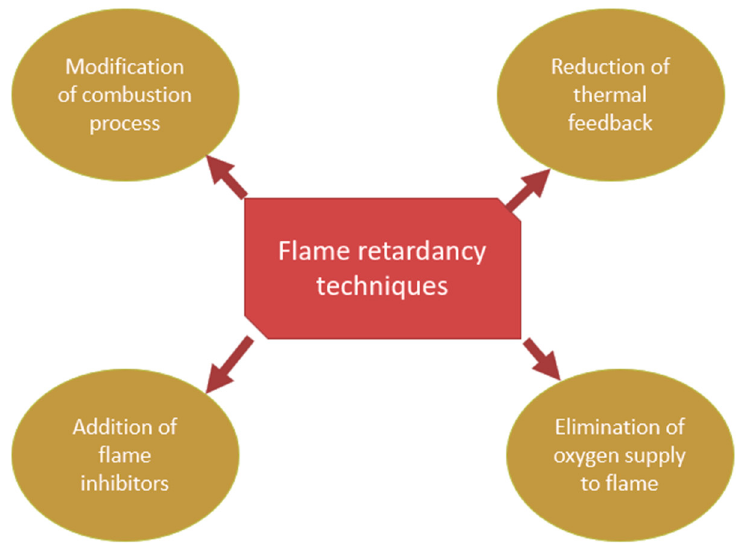
Figure 6. Methods of flame